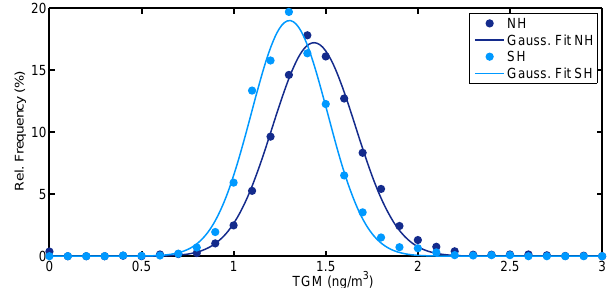
Fig. 3. Histogram showing the distribution of mercury concentrations measured during NH influence (dark blue) and SH influence (light blue). The dots represent the relative frequency for the particular bin, the lines represent Gaussian curves fitted to the data, indicating that the data are normally distributed.